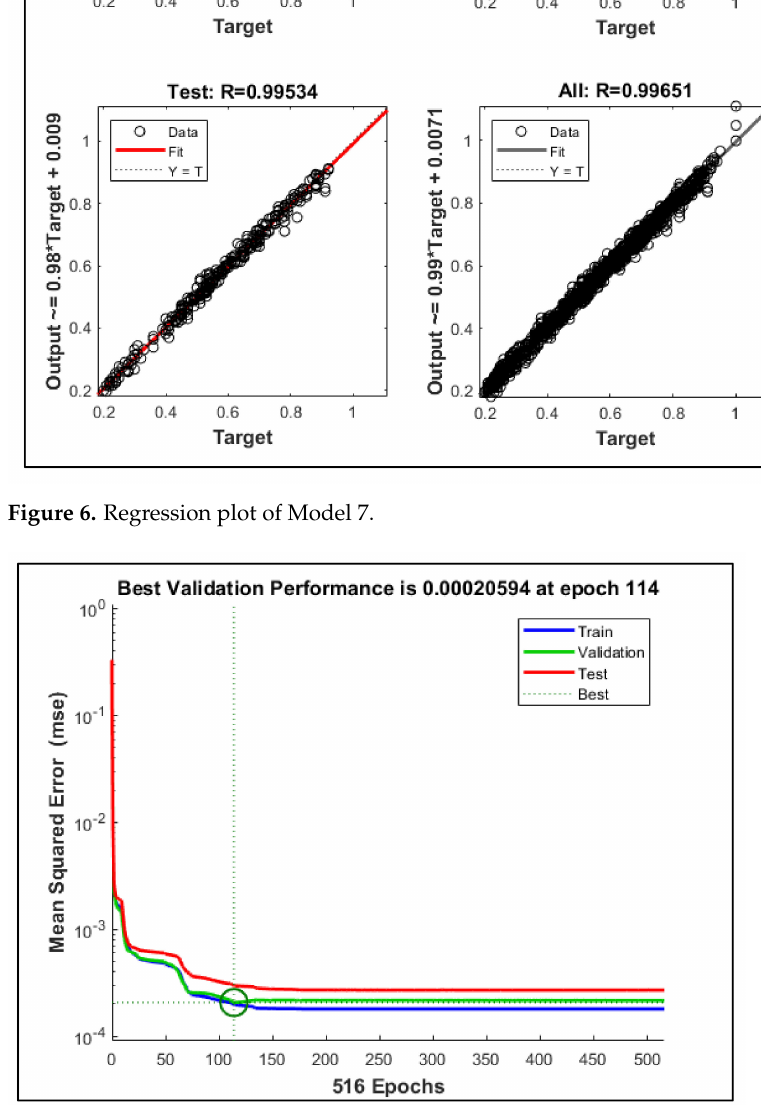
Figure 7. Validation performance of Model